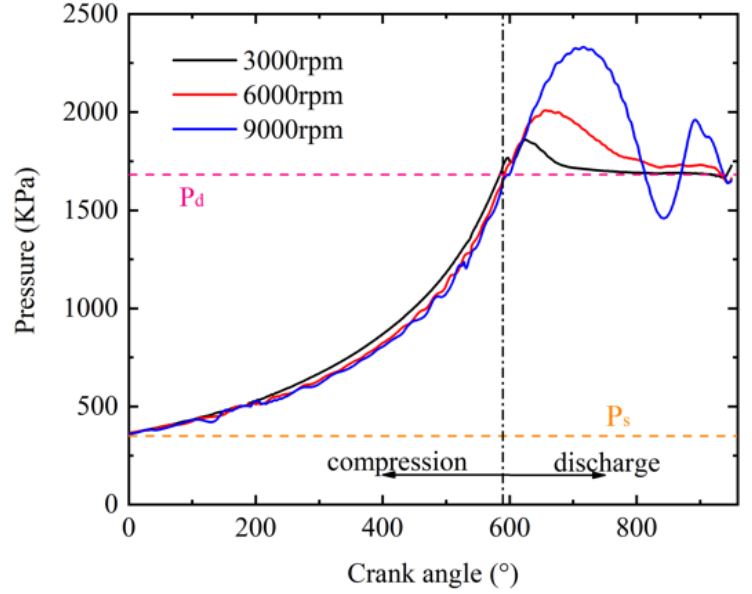
Figure 11. Chamber pressure change with the crank angle.